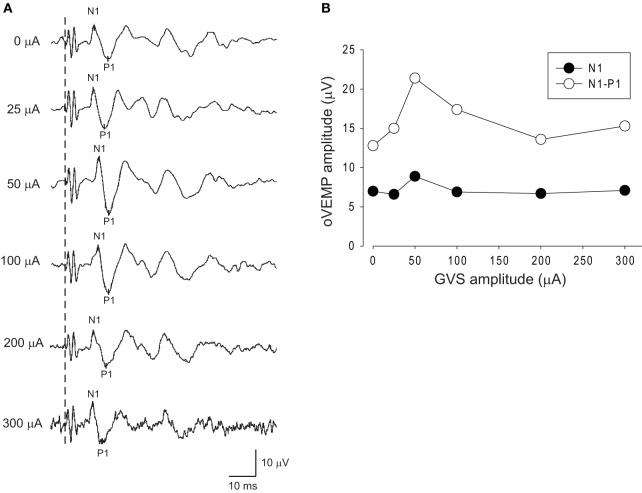
Changes in oVEMPs to bone-conducted vibration (BCV) during application of noisy galvanic vestibular stimulation (GVS) in a representative subject. (A) oVEMP responses to BCV during application of various intensities of GVS in a 58 year-old healthy subject. (B) Changes in the N1 and N1–P1 amplitudes of oVEMP responses during application of noisy GVS. In this subject, GVS at an intensity of 50 µA increased the amplitude of oVEMP responses, whereas further increases in intensity caused deterioration.